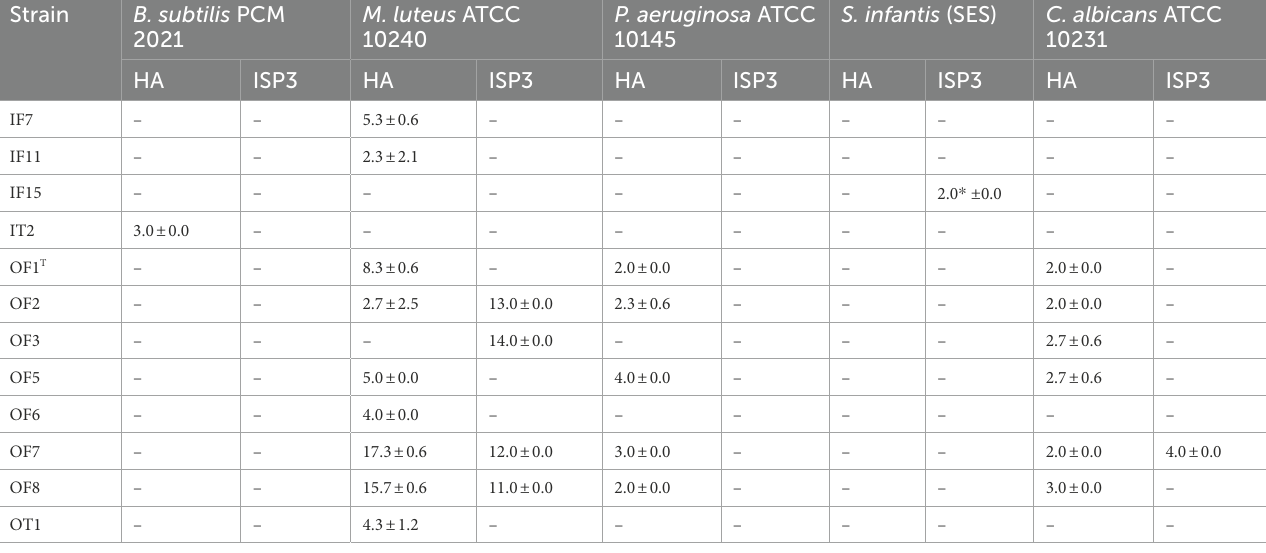
TABLE 3 Antimicrobial activity of isolates from the saline soil adjacent to Lake Lonar using a standard plug assay.